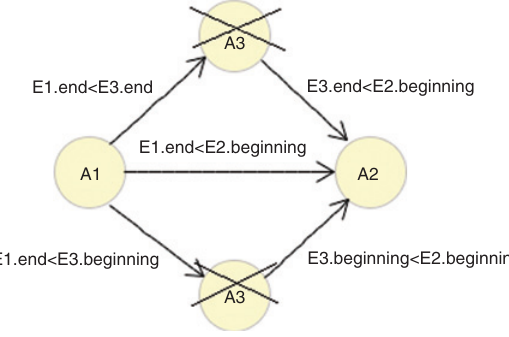
Figure 4: MSDR-CP Rule Represented by a Graph.